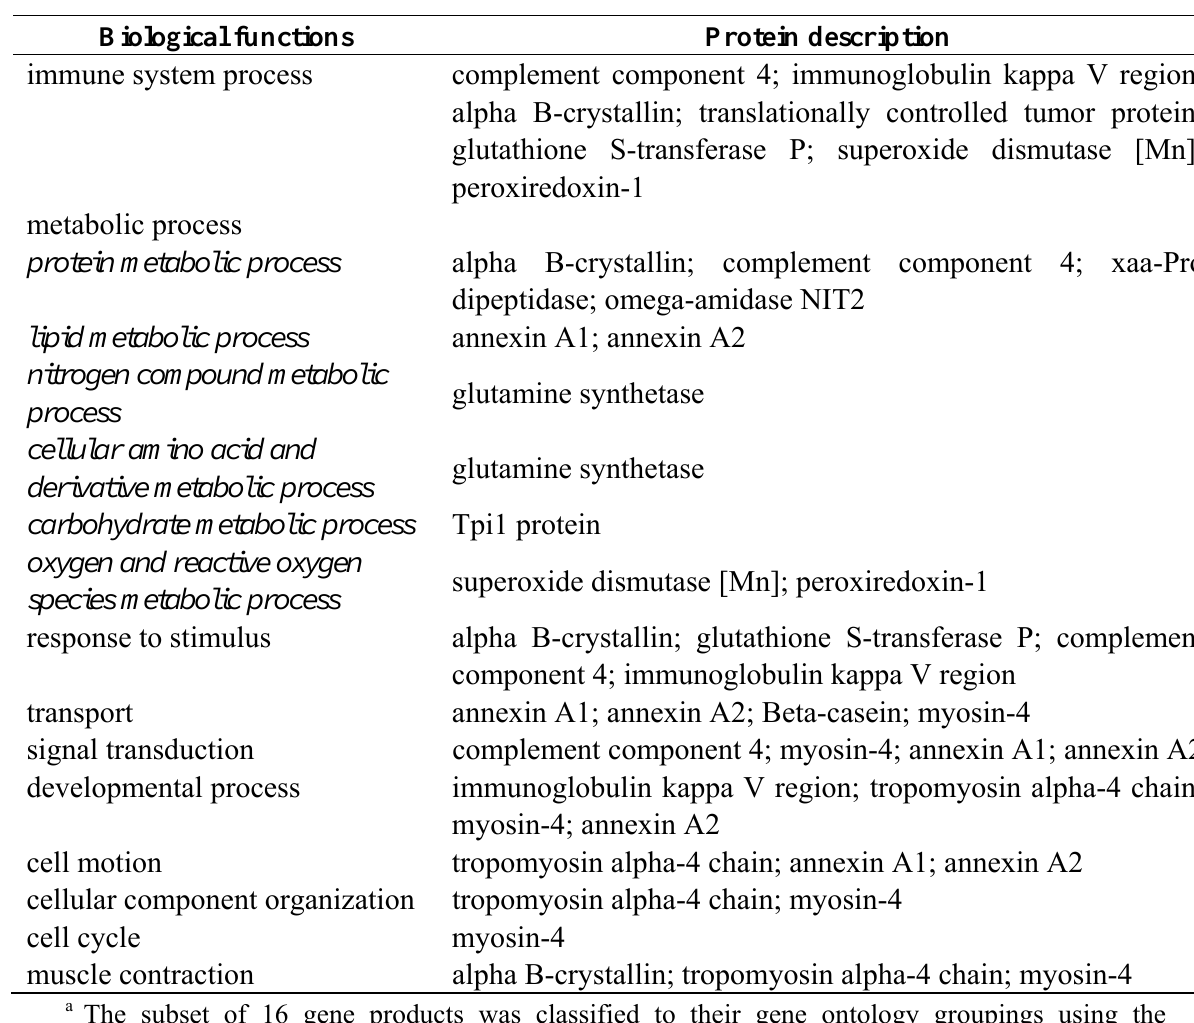
Table 2. Classification of differentially regulated proteins according to biological functions.